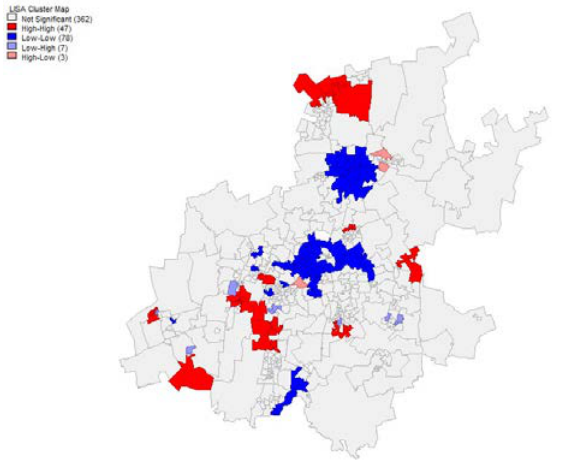
With respect to the intensity of poverty, in 2001 (refer Figure 10) , the observed global Moran’s I is 0.23 and clusters of wards with lower rates of deprivation can be observed in the central areas of the city of Tshwane, city of city of Johannesburg and in Mogale (Western part of Gauteng). In 2011 (refer Figure 11), an observed low value of global Moran’s I (0.16) for the intensity of poverty signaled a weak occurrence of spatial autocorrelation. Clusters of wards with higher rates of poverty deprivation can be observed in Ekurhuleni (Eastern part of the province). In the core areas of the province (city of Johannesburg and city of Tshwane) wards with higher and lower rates of poverty deprivation can also be observed.